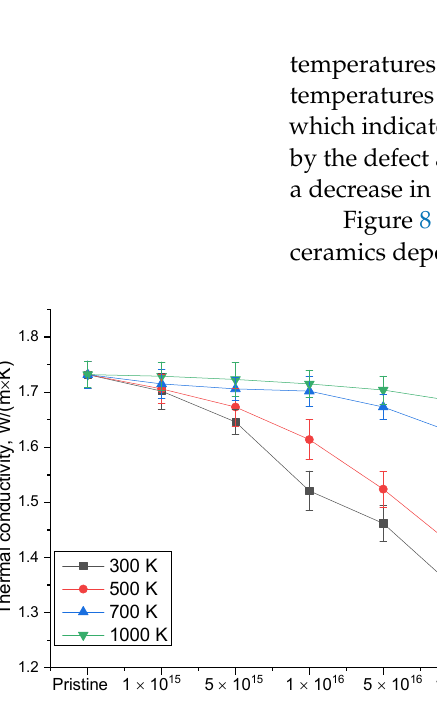
( b ) Figure 7. ( a ) Results of the change in the crack resistance value of ceramics depending on the irra- diation conditions; ( b ) Results of the change in the crack resistance value, depending on the irra- diation conditions. As can be seen from the data presented, the change in the crack resistance value of ceramics, as well as the crack formation resistance, has a similar pronounced dependence